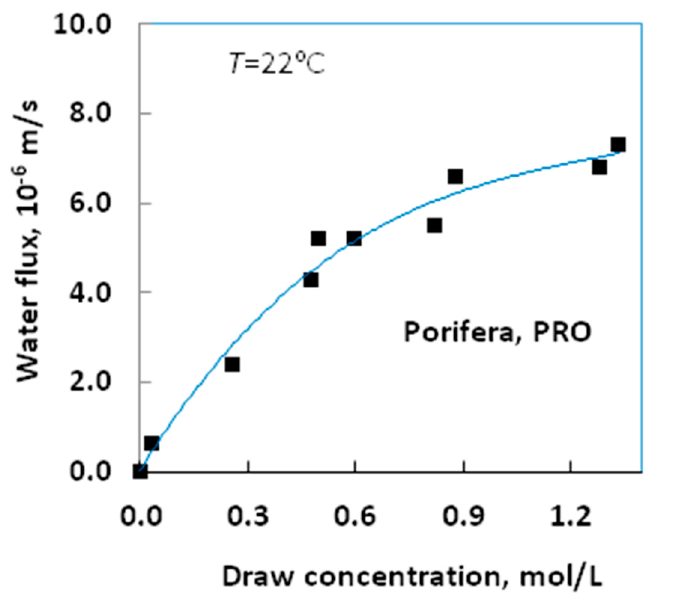
Figure 3. Osmotic water flux of the Porifera membrane as a function of the draw NaCl concentration in PRO mode. Experiments were performed at 22 °C and at 0.20–0.25 m/s cross-flow velocity with DI water at the feed side and without a hydraulic pressure difference (the continuous line is a fitted curve to the measured points).